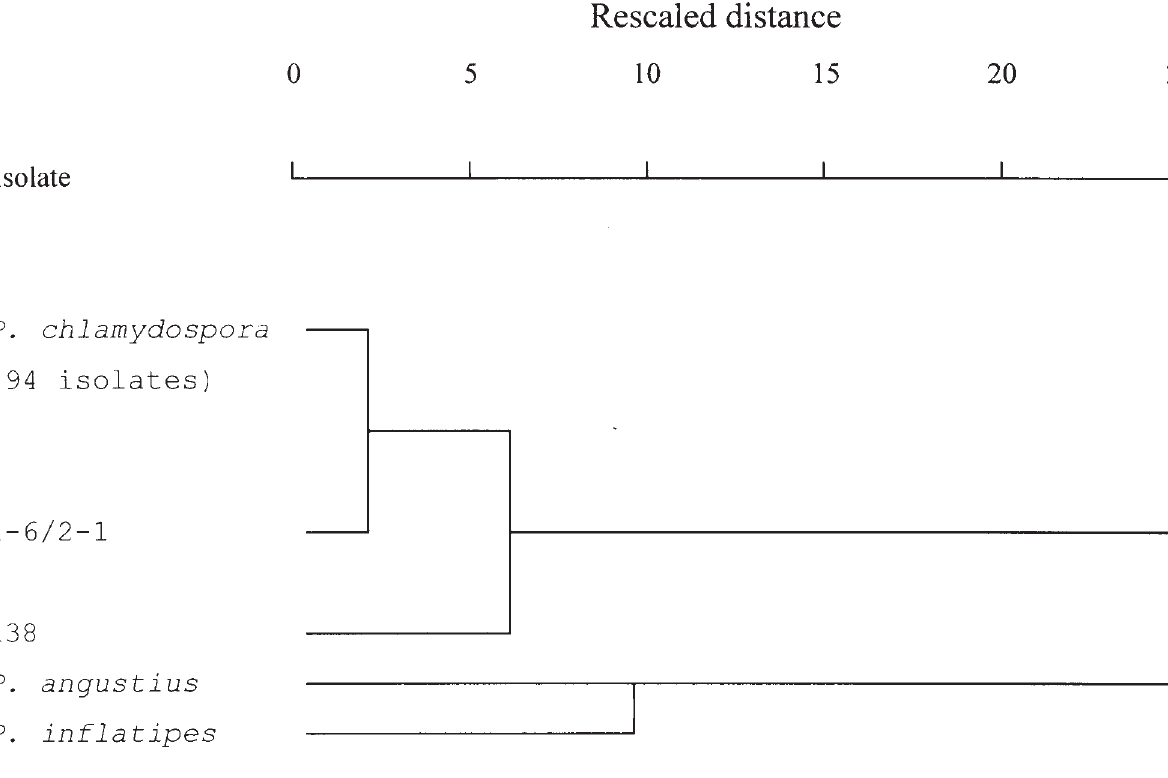
Fig. 3. Dendrogram from cluster analysis of genetic distance among isolates of Phaeomoniella chlamydospora